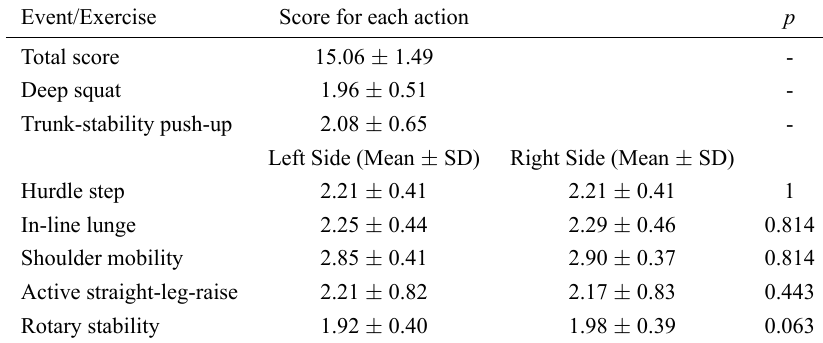
Table 1. FMS test results (n = 48).